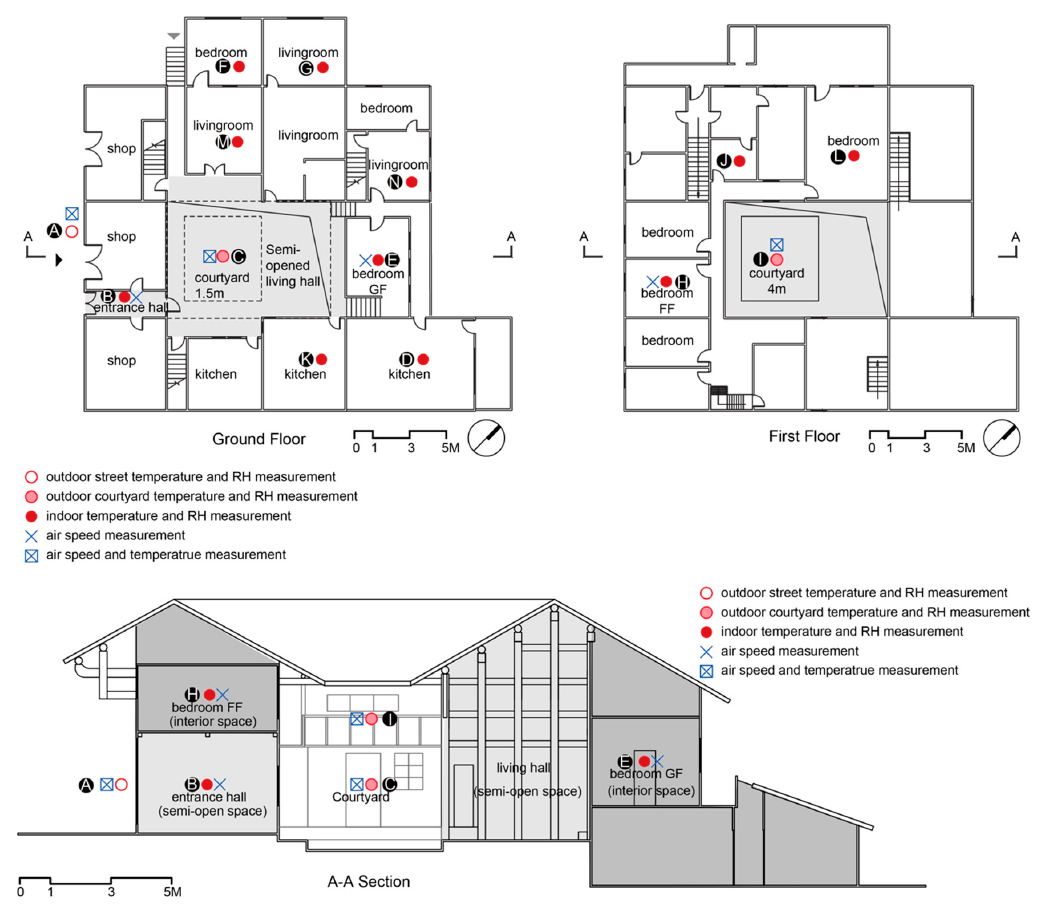
Figure 4. Images of: ( a ) wood plank, ( b ) stone, and ( c ) hollow brick walls.